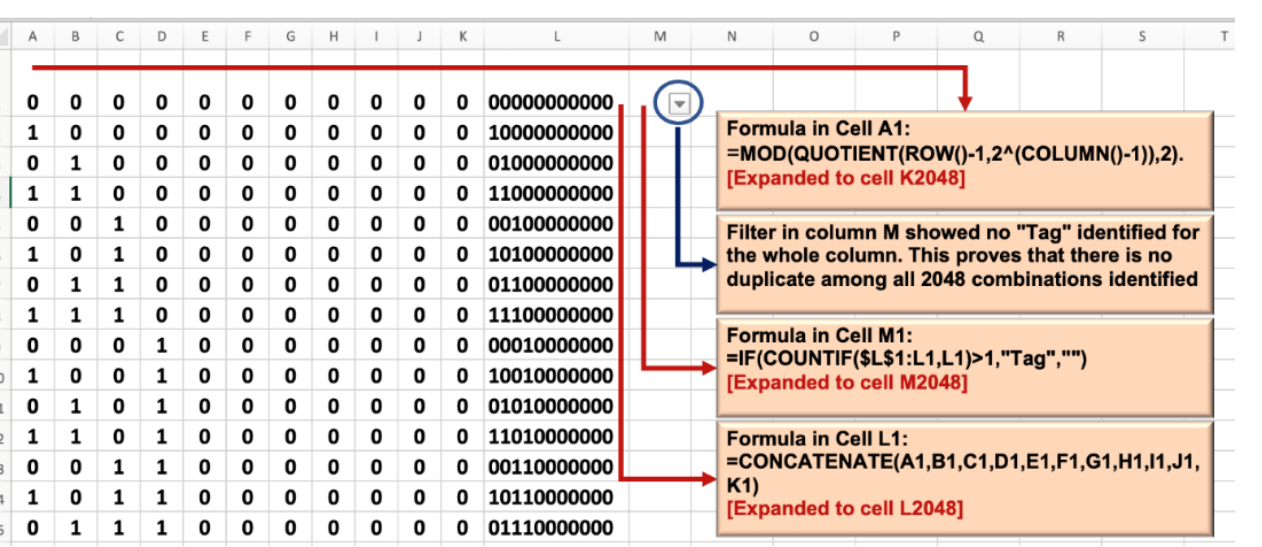
Figure 3. Turning unique bits into unique combinations of alphabetical code of predictors. Figure 4. Removing the combinations which contain the mutually exclusive predictors .